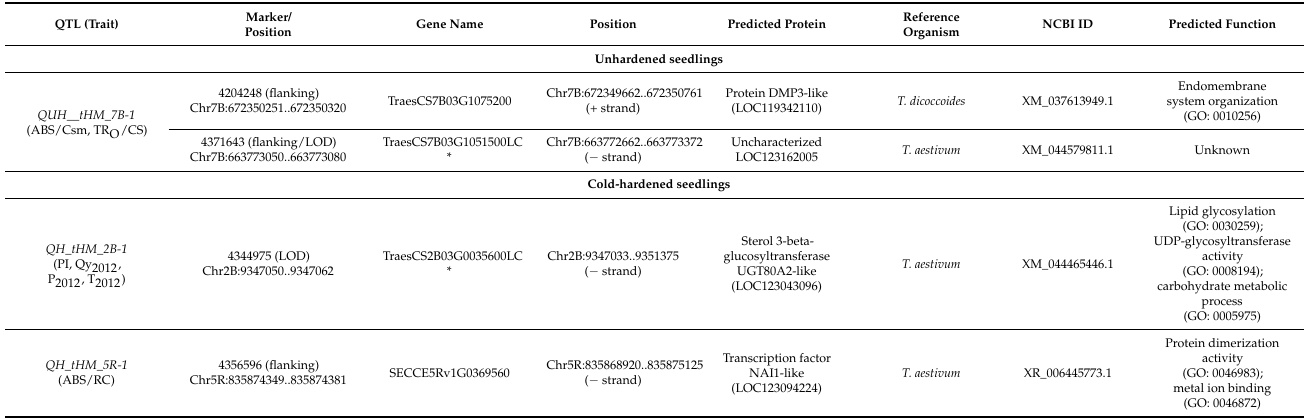
Table 2. In silico identification of candidate genes found within the significant QTL regions associated with the seedling damage caused by the M. nivale infection (P index), the M. nivale infection tolerance (T index), photosynthesis quantum efficiency (Qy 2012 ) as well as chlorophyll a fluorescence parameters in winter triticale seedlings of the DH ‘Hewo’ x ‘Magnat’ lines mapping